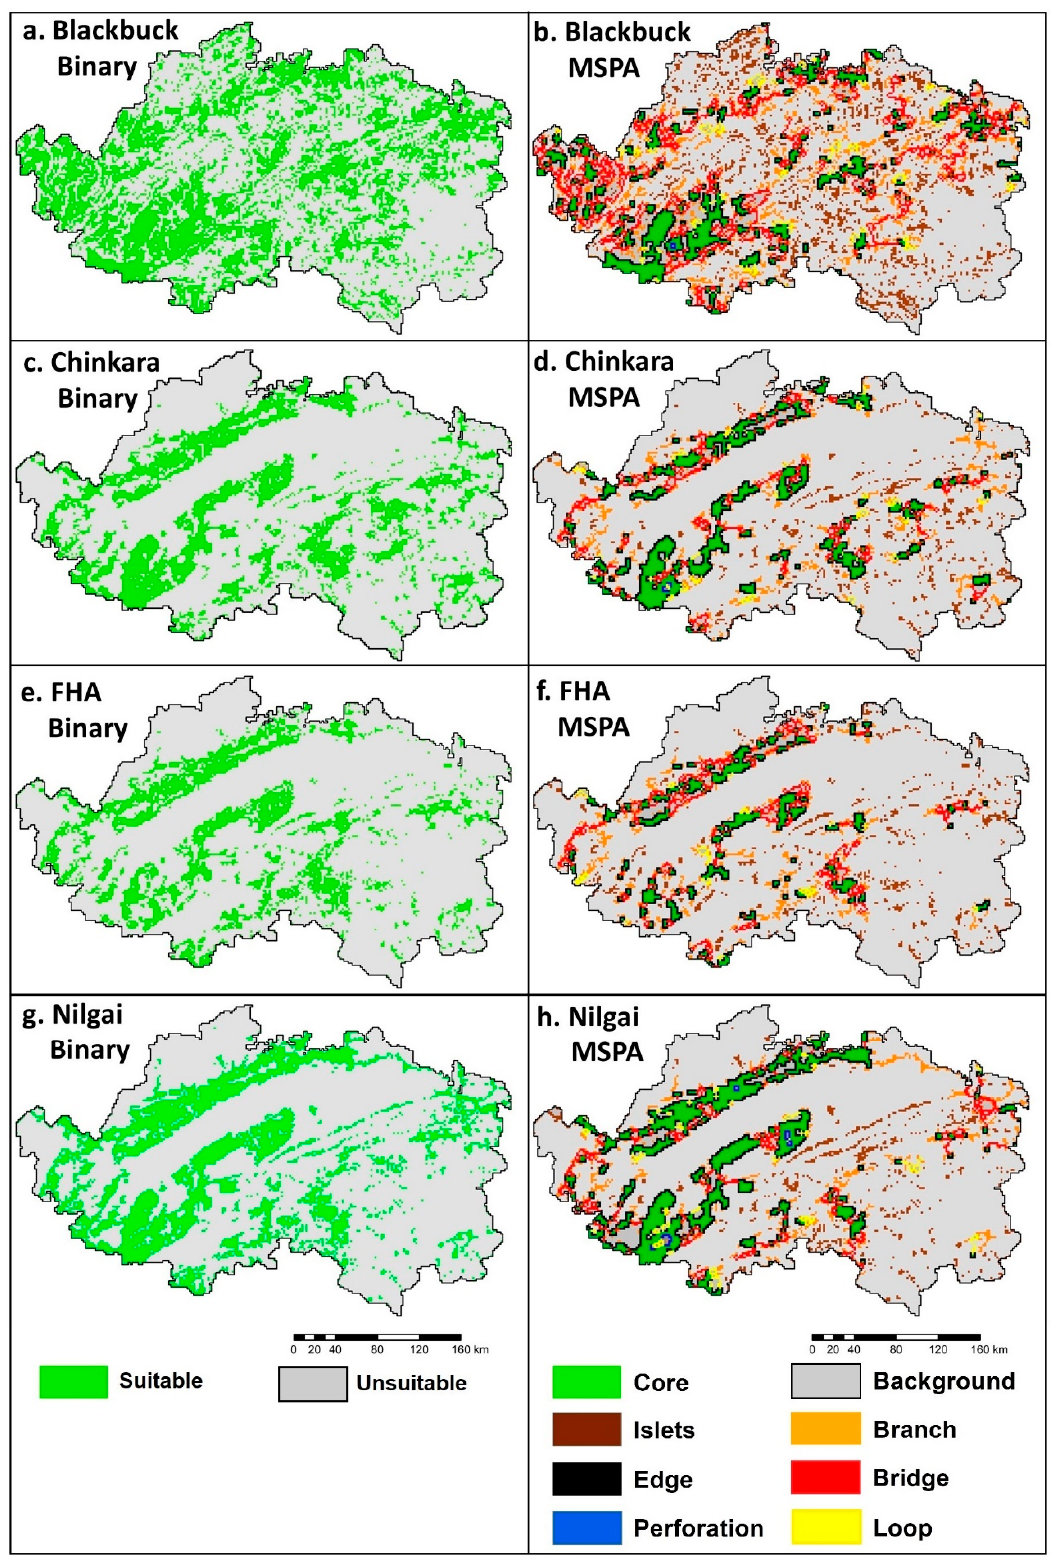
Figure 6. Binarized suitability maps and MSPA output maps of all four focal species. ( a ) Blackbuck binarized suitability map, ( b ) Blackbuck MSPA output, ( c ) Chinkara binarized suitability map. ( d ) Chinkara MSPA output, ( e ) Four-horned antelope binarized suitability map, ( f ) Four-horned antelope MSPA output, ( g ) Nilgai binarized suitability map, ( h ) Nilgai MSPA output. MSPA